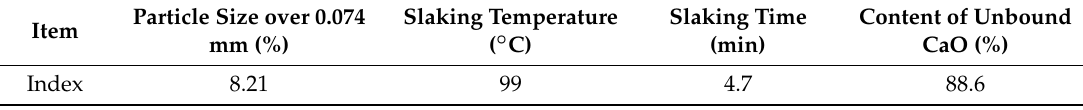
Table 2. Performance index of the lime.